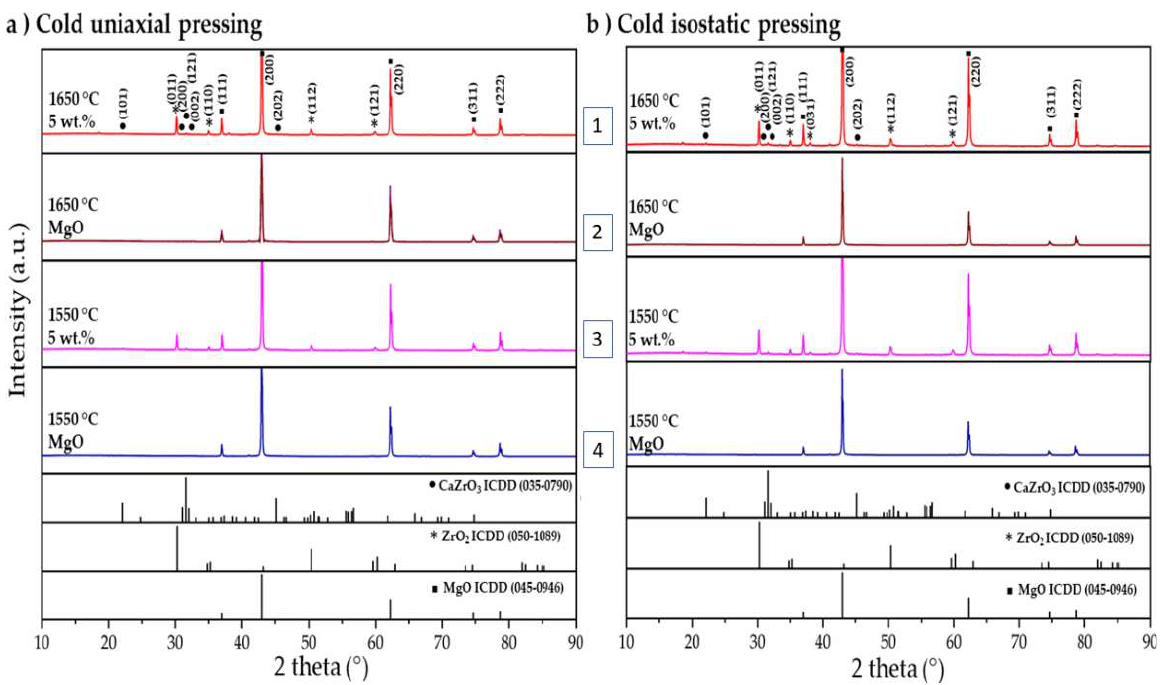
Figure 2. XRD pattern of the sample 100 wt.% MgO (brown and blue line, 2 and 4) and MgO sample containing 5 wt.% of ZrO 2 nanoparticles (red and pink line, 1 and 3) sintered at 1550 °C and 1650 °C, pressed by: ( a ) Cold uniaxial pressing (CUP) and ( b ) cold isostatic pressing after cold uniaxial pressing (CUP + CIP).